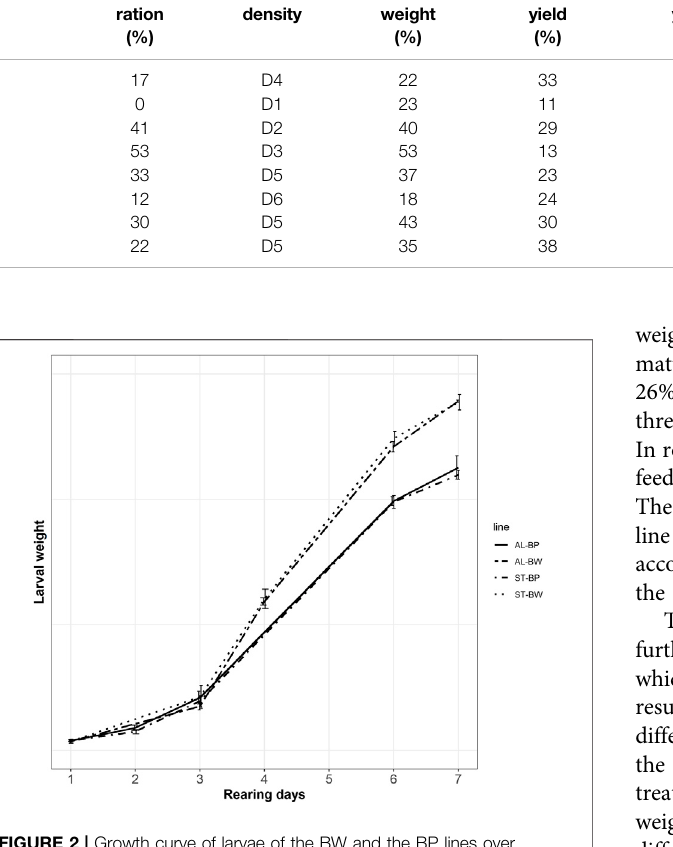
FIGURE 2 | Growth curve of larvae of the BW and the BP lines over rearing days during the feeding trial (error bars indicate standard deviation). AL-BP: The Base population line at ad-libitum feeding ration; AL-BW: The Body weight line at ad-libitum feeding ration; ST-BP: The Base population line at standard feeding ration; ST-BW: The Body weight line at standard feeding